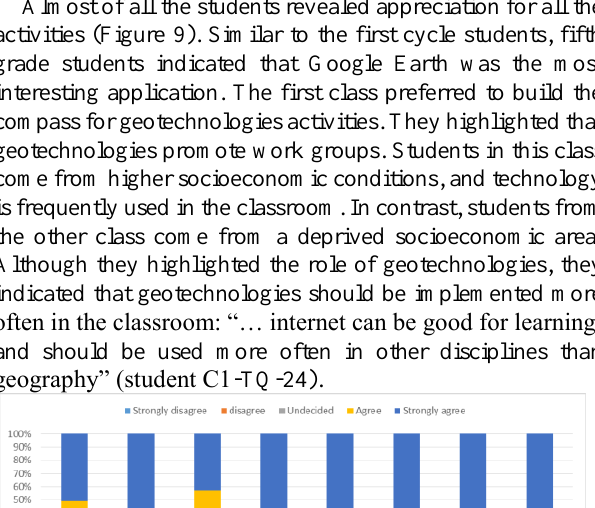
Figure 6: Second and fourth grade students’ perceptions about geotechnologies beliefs